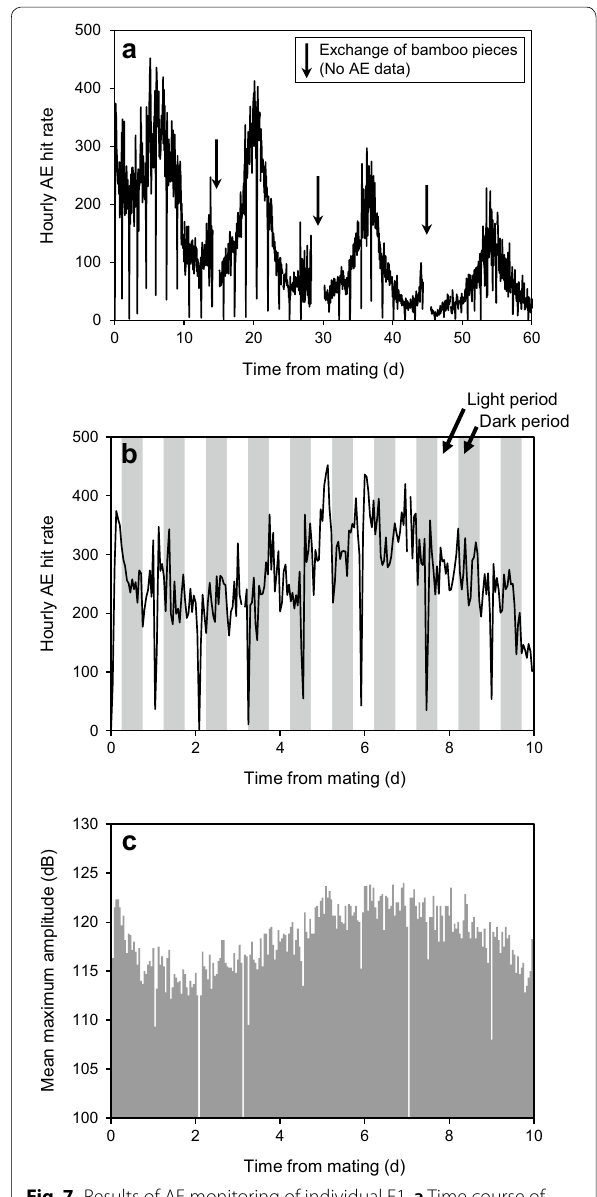
Fig. 7 Results of AE monitoring of individual F1. a Time course of the hourly AE hit rate for 60 days after mating. b Time course of the hourly AE hit rate for 10 days after mating, with light and dark periods indicated on the background in white and gray , respectively. c Time course of the mean maximum amplitude of AE for 10 days after